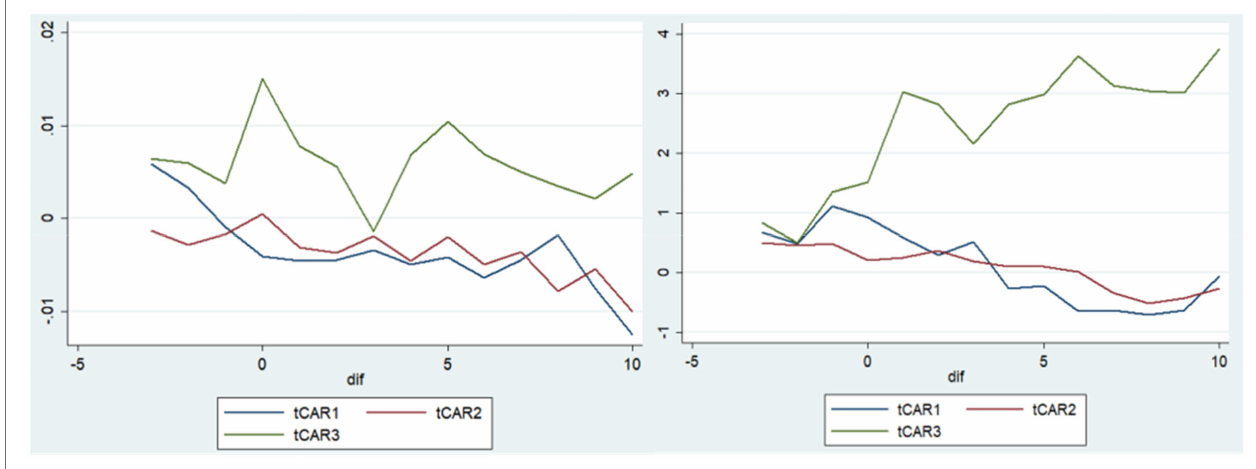
FIGURE 4 | CAR comparison based on type of bonds (Left: Mainland China, Right: Hong Kong).